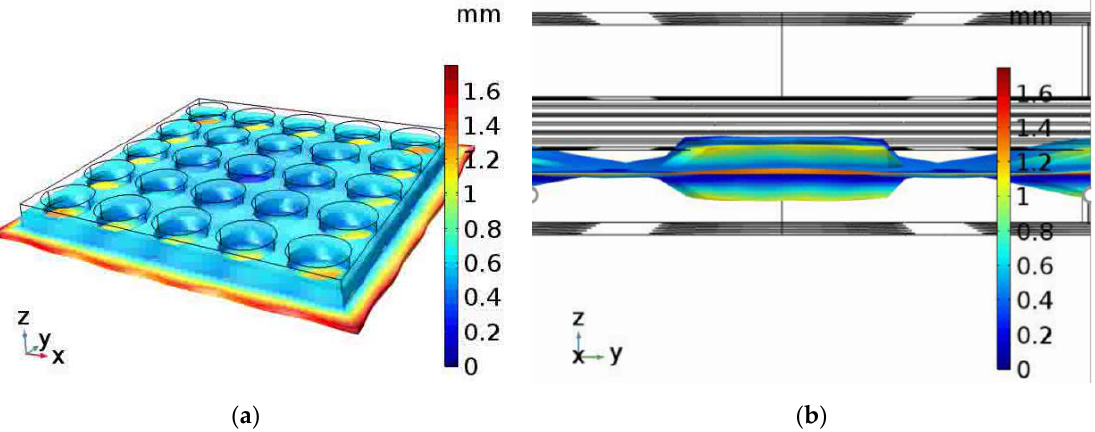
Figure 16. Calculated deformation of the sensor with elastic silicone plates with openings ( a ) and magnified side view of the bulging effect of the dielectric elastomer between two openings ( b ) [97].